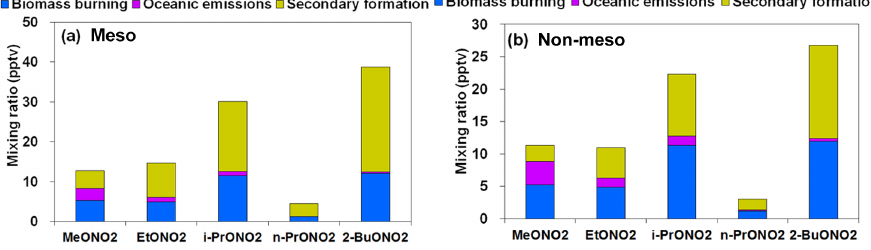
Figure 9. Source contributions to individual alkyl nitrates in (a) meso and (b) non-meso scenarios at TW (in summed mixing